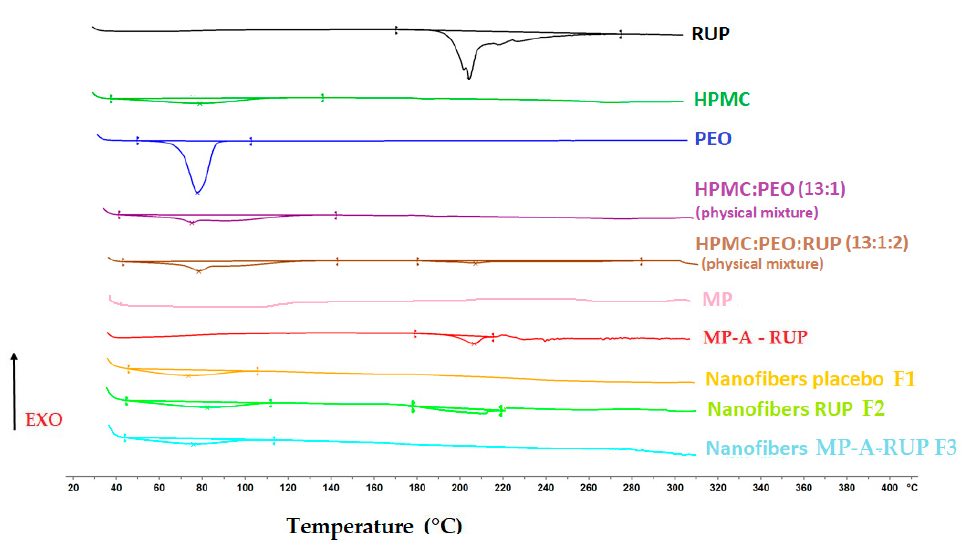
Figure 2. DSC thermograms of pure RUP; HPMC; PEO; physical mixtures of HPMC:PEO (13:1) and HPMC:PEO:RUP (13:1:2); MP; MP-A-RUP; and the obtained nanofibers (placebo (F1), those with RUP in a powder form (F2), and those with MP-A-RUP (F3).